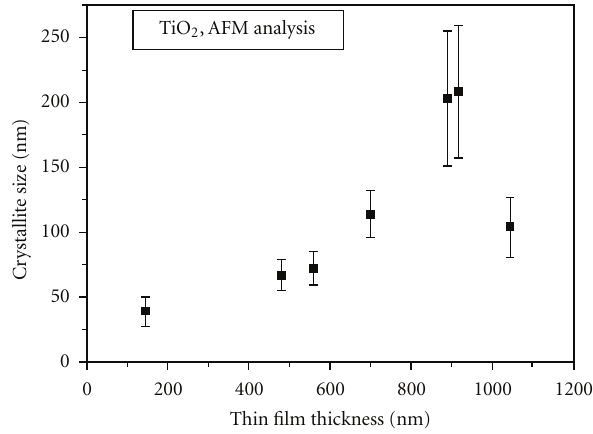
Figure 7: Results of AFM analysis of average particle sizes in anatase TiO 2 thin films in dependence on thin film thickness.